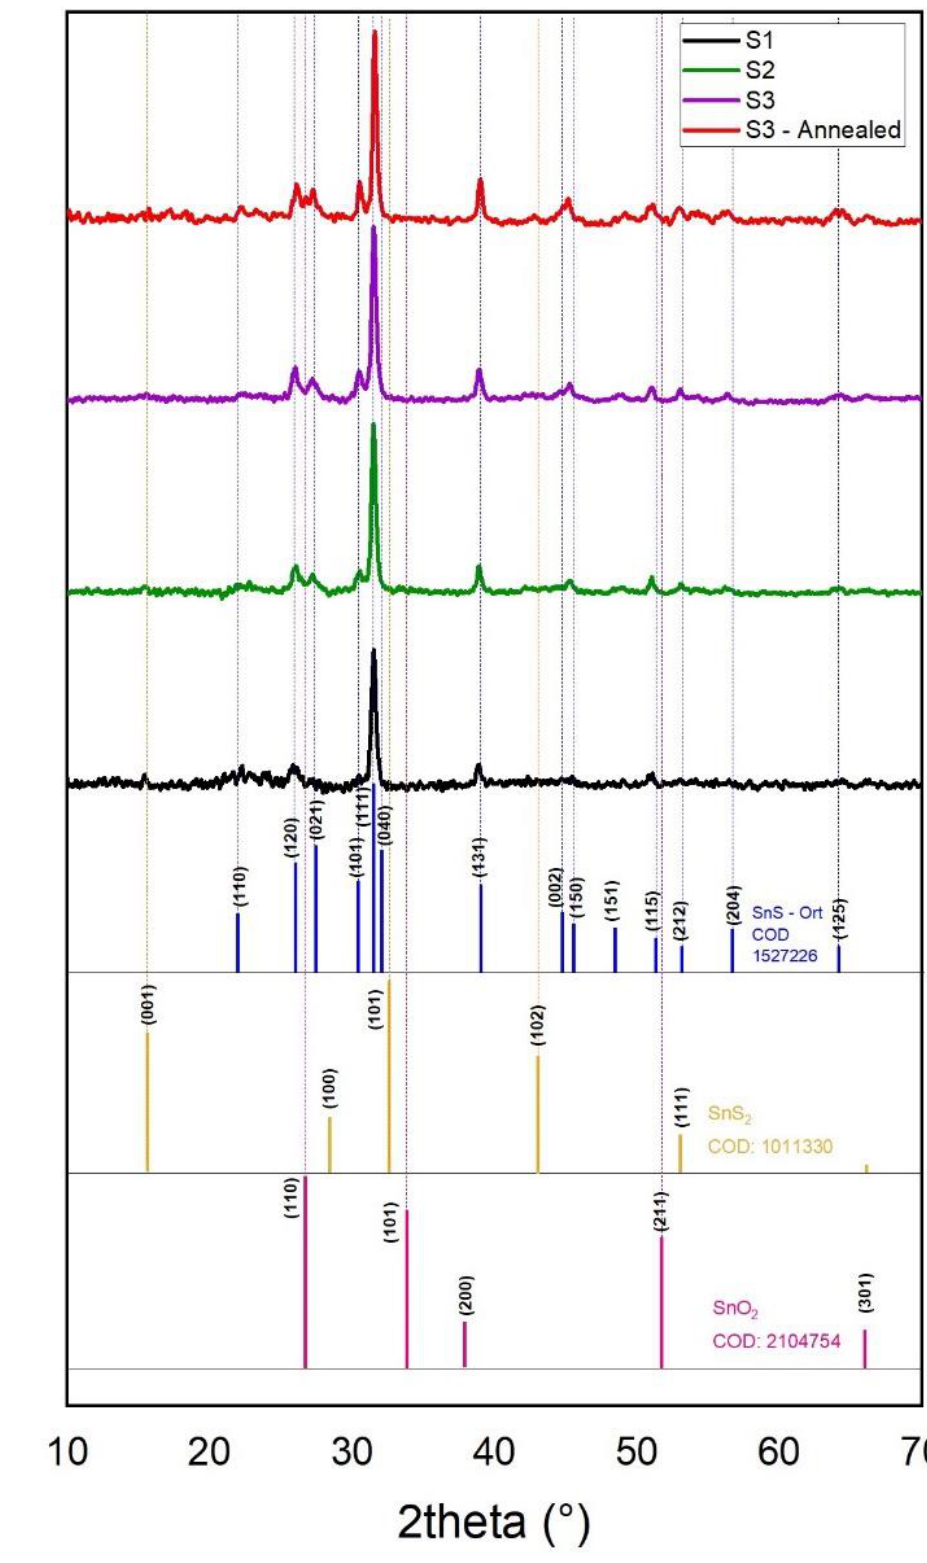
Figure 1. XRD pattern of samples S1, S2, S3 as deposited and S3 after the thermal annealing.